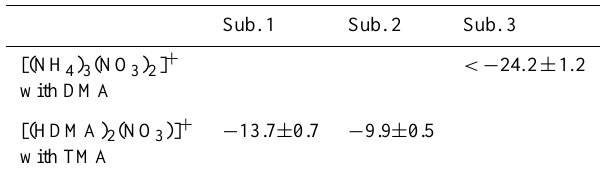
Table 5. 1G values (kJ/mol) for the substitution reactions of nitrate clusters at